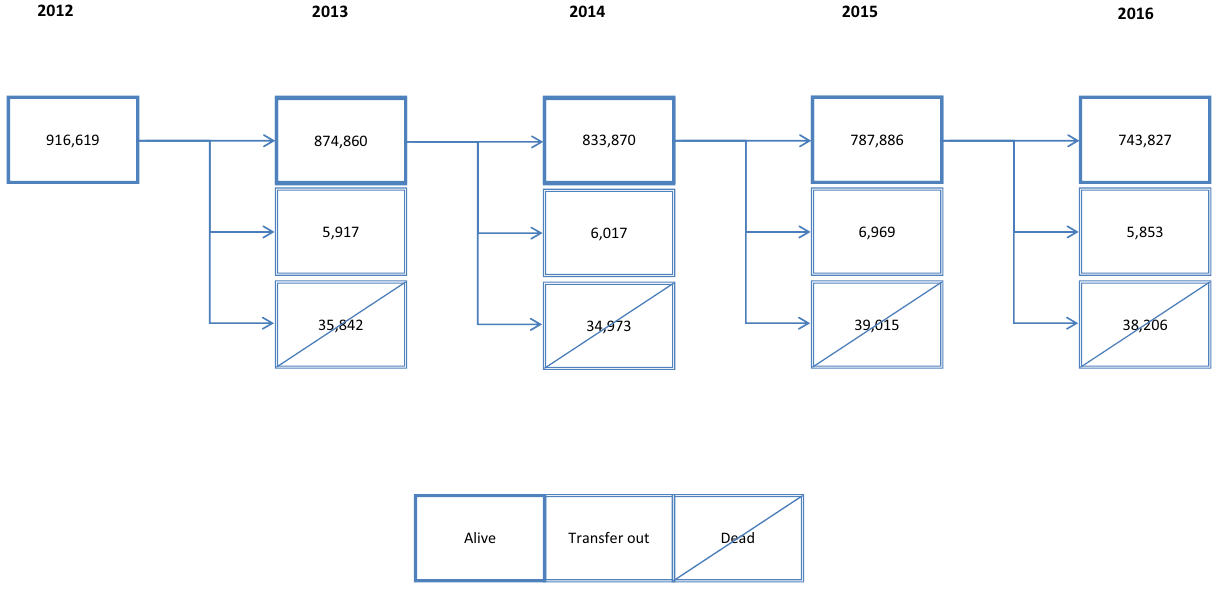
Figure 1. Longitudinal Flow Chart of study period (year 2012–2016; N = 916,619